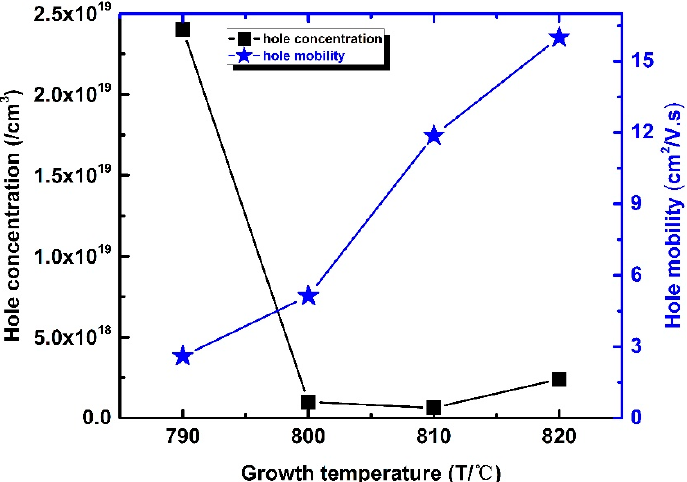
Figure 4. Hole concentration and mobility tested by Hall measurement at RT for the samples (color online).